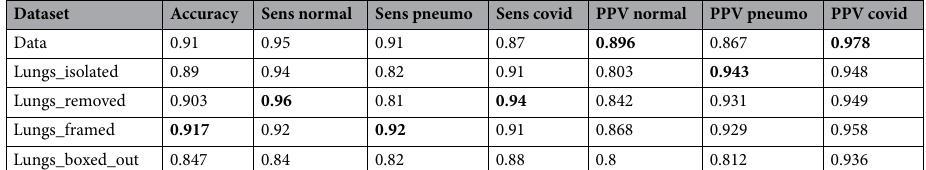
Table 3. Performance metrics using different data preparation strategies classified with COVIDNet-CXR3-A model: sens and pneumo stand for sensitivity and pneumonia, respectively. Bold values correspond to best performance metric for dataset in the same row.